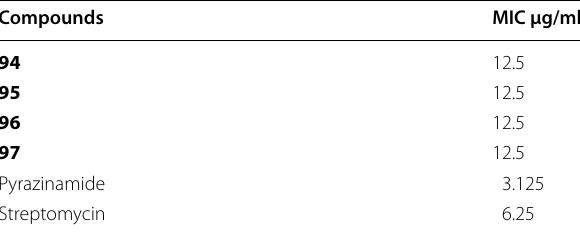
Table 30 Anti-tubercular activity of synthesized deriva-